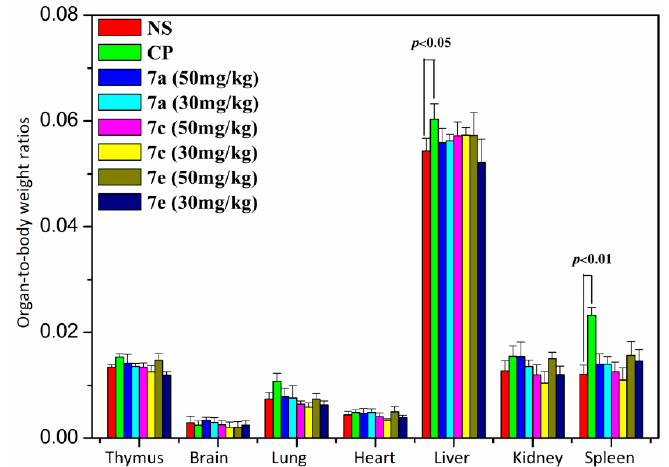
Figure 2. Effects of different dosage of 7a , 7c , and 7e on organ index in H22 bearing mice. Normal saline (NS) and cyclophosphamide (CP) were utilized as a negative control and positive control, respectively. p < 0.05, p < 0.01 compared with untreated control group.